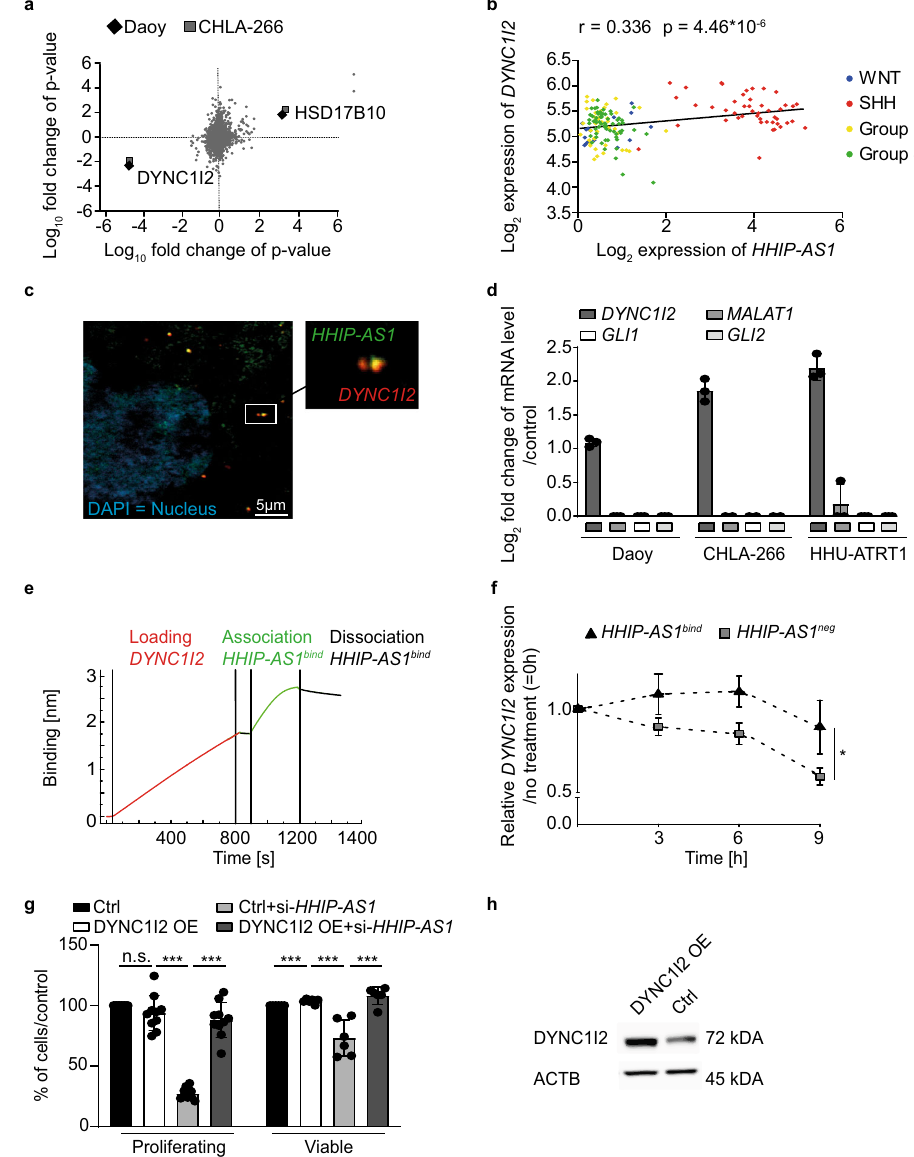
Fig. 3 Identi fi cation and functional validation of HHIP-AS1 downstream targets reveals that HHIP-AS1 binds to mRNA of DYNC1I2 . a Scatter plot indicates the correlation analysis of RNA sequencing ( x -axis) and protein mass spectrometry (y-axis) data in two different cell models (Daoy and CHLA- 266) upon HHIP-AS1 knockdown (using sh- HHIP-AS1#1 and sh- HHIP-AS1#2 ) versus control cells (sh- scr , n = 3 independent samples per condition and cell model). b Scatter plot displaying expression correlation of DYNC1I2 and HHIP-AS1 sequencing data comparing FPKM expression values in 167 MB patient samples. Samples are color coded for MB subgroups. Statistics were done by Pearson correlation. c Representative image of co-localization of HHIP-AS1 and DYNC1I2 mRNA in Daoy obtained through two-color fl uorescence in situ hybridization (FISH). White frame indicates the location of the zoom out picture at the right side. Green: HHIP-AS1 lncRNA, red: DYNC1I2 mRNA, blue: DAPI, Nucleus. Scale bar: 5 µ m. This experiment was repeated twice with similar results. d Enrichment of DYNC1I2 mRNA upon HHIP-AS1 raPOOL pulldown in Daoy and CHLA-266 cell lines and HHU-ATRT1 primary cells. Bar graphs are presented as the mean ± SD of three independent experiments. e Bio-Layer interferometry was used for detecting direct interaction between DYNC1I2 mRNA and HHIP-AS1 . f DYNC1I2 mRNA stability upon transfection of a control ( HHIP-AS1 neg ) or the HHIP-AS1 interacting sequence ( HHIP-AS1 bind ). Calculation was done in comparison to the mRNA level at time point “ 0 h ” in each condition. Data are presented as the mean ± SEM of fi ve independent experiments; Student´s two-sided t -test; * p < 0.05. g Bar graph indicating the proliferation rate or viability of Daoy cells in control condition (Ctrl), upon overexpression of DYNC1I2 (DYNC1I2 OE) and upon transient HHIP-AS1 -knockdown (si- HHIP-AS1 ) in DYNC1I2 overexpression (DYNC1I2 OE + si- HHIP- AS1 ). Data are represented as the mean ± SD of at least six independent experiments normalized to the control condition. Student ’ s two-sided t -test; *** p < 0.001; n.s. not signi fi cant. h The immunoblot shows a representative blot of DYNC1I2 protein expression in control (Ctrl) or DYNC1I2- overexpressing (DYNC1I2 OE) cells. ACTB immunoblotting was used as loading control. This experiment was done twice with similar result. Source data and exact p -values are provided as a “ Source Data fi le ”